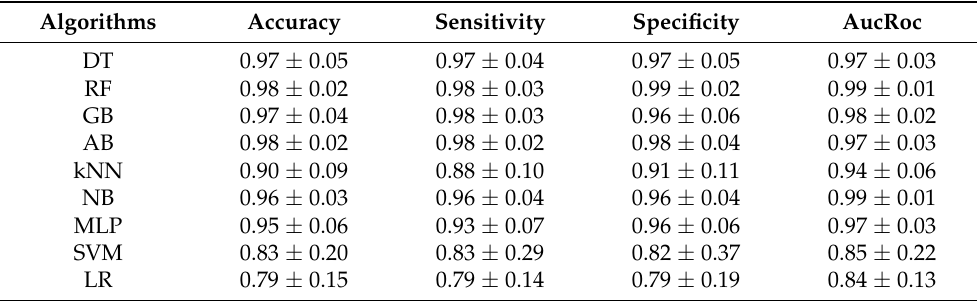
Table 3. Scores from stratified tenfold cross-validation (CV) evaluation metrics averaged over the seven subjects (mean ± standard deviation) using the features extracted from the acceleration signals along the three axes.